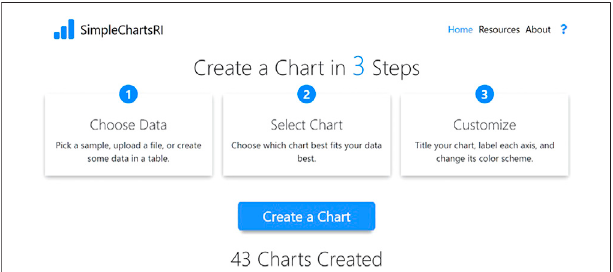
FIGURE 5 | simplechartsri.com choose data